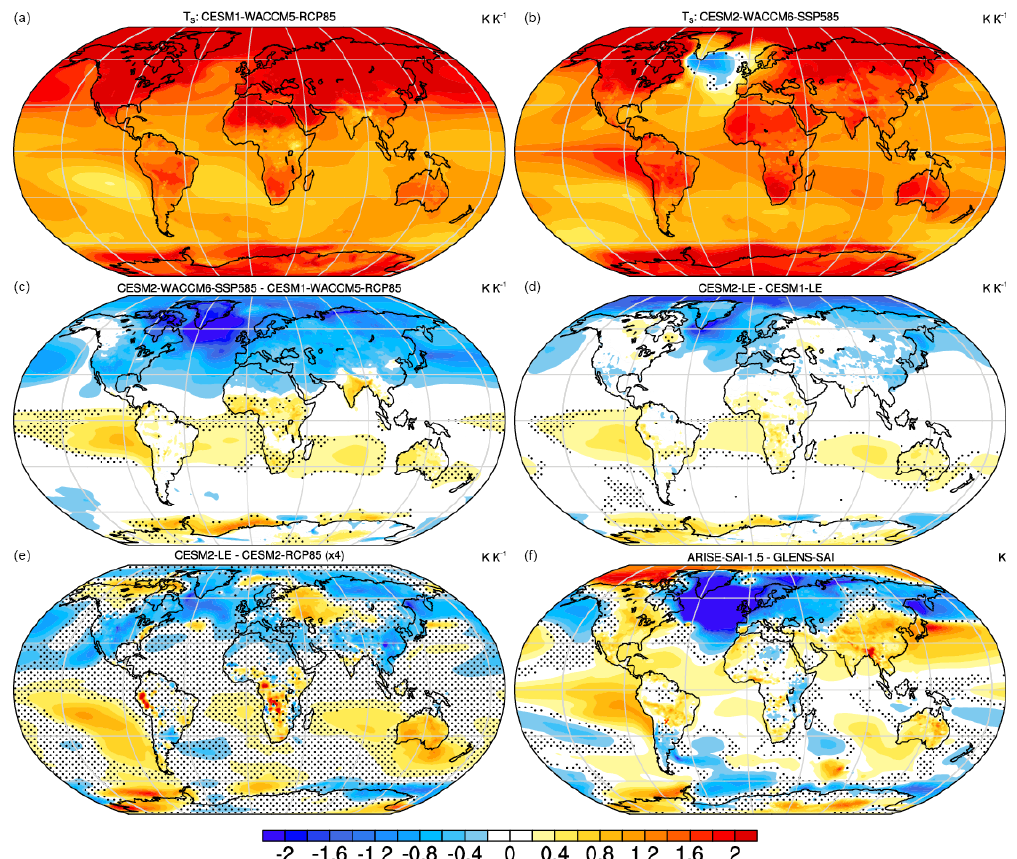
Figure 2. Normalized response in near-surface air temperature ( T S ) estimated from the change between 2020–2039 and 2050–2069 per degree global warming for unmitigated (a) CESM1-WACCM5-RCP85 and (b) CESM2-WACCM6-SSP585 simulations, and (c) their dif- ference ( a minus b ). Also shown is (d) the analogous difference for CESM1-LE and CESM2-LE and (e) CESM2-RCP85 and CESM2-LE (multiplied by 4 for clarity using a single color bar). The difference between the geoengineered climate states in ARISE-SAI-1.5 and GLENS- SAI is shown in panel (f) . Units for all panels are KK − 1 , except in panel (f) where units are K, and stippled regions indicate differences that are less than twice the ensemble standard